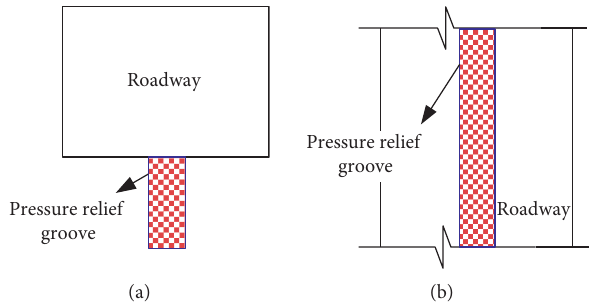
Figure 3: Schematic diagram of cutting groove in the floor. (a) Sectional drawing; (b) vertical view.